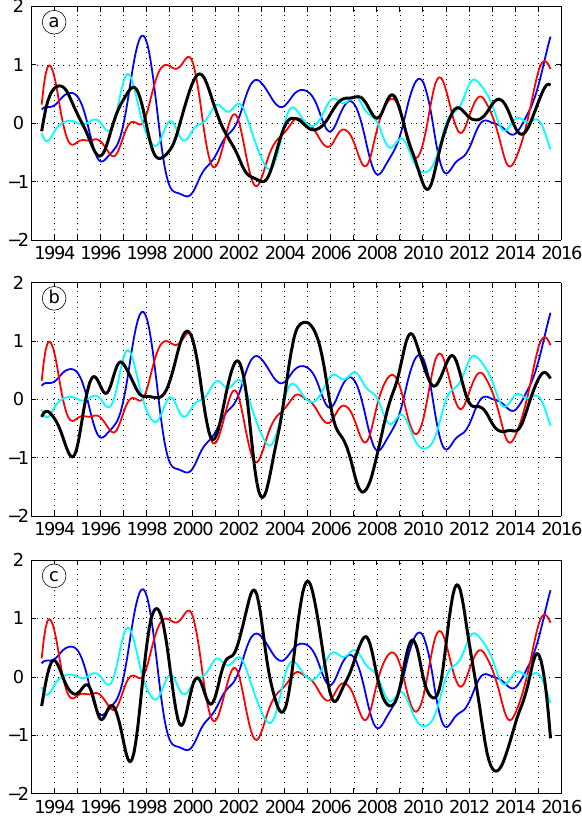
Figure 9. Southern Annular Mode (red) and Niño 3.4 index (blue) and South Atlantic Subtropical Dipole Mode (cyan) in compari- son with meridional transports in the Brazil Current (black) derived from the time series in Fig. 5. Positive (negative) anomalies for the Brazil Current transport represent low (high) transports of this cur- rent. (a) 24 ◦ S; (b) 35 ◦ S (the Brazil Current transport has been di- vided by a factor of 1.5 for easier comparison); (c) 38 ◦ S (the Brazil Current transport has been divided by a factor of 2.5 for easier com- parison). The linear trend was removed from all time series, and the time series were smoothed with a 12-month Butterworth filter.